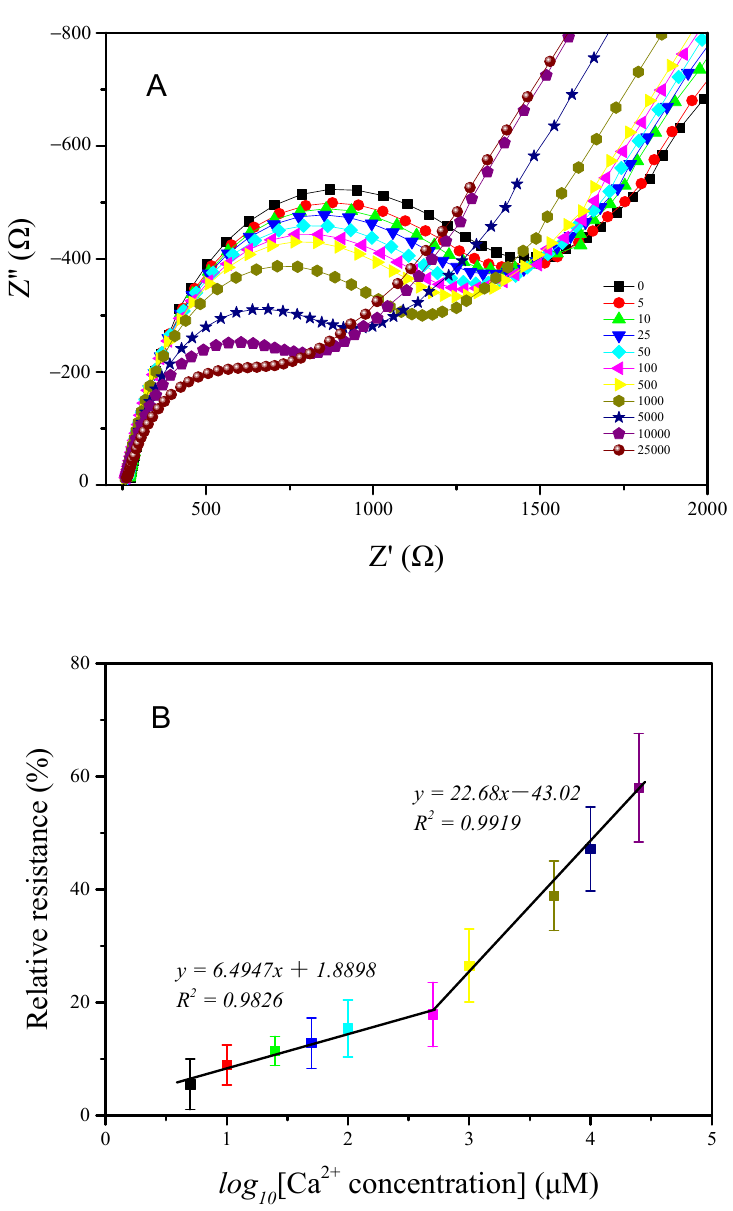
Figure 9. ( A ) Electrochemical impedance spectra of the GCE/SWNT/DNAzyme for different Ca 2+ concentrations in the range of 1 µ M to 25 mM; ( B ) the linear relationship between the relative resistance and the logarithm of the Ca 2+ concentration.